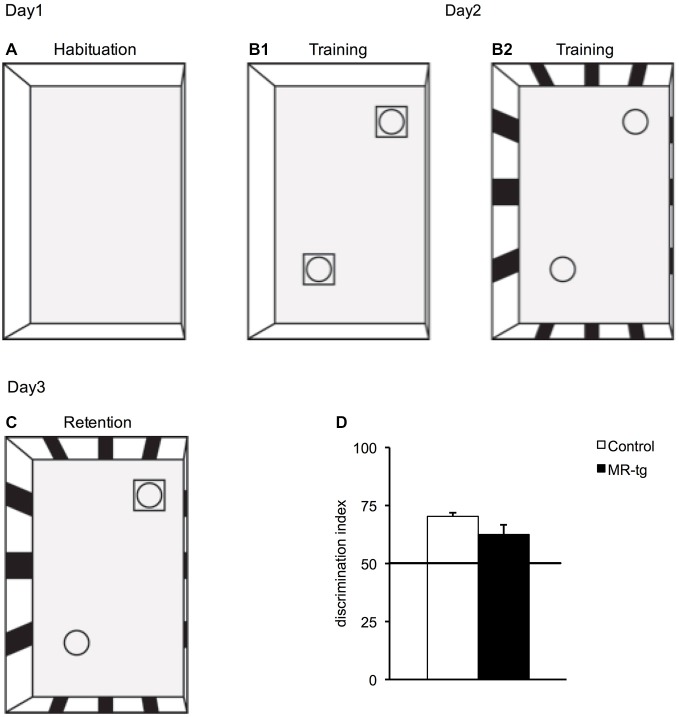
Effects of MR overexpression in object-in context. (A–C) Schematic representation indicating the setup of the object-in-context experimental paradigm: (A) On day1, mice were initially habituated in context A that had no objects. (B1) On day2, during training, mice were placed in the same context (context A) but with two identical objects and then placed in a novel context (context B) with two identical novel objects (B2). (C) On day3, the mice were placed in the context B but with one object being replaced by an object from the first context. (D) MR-tg and control mice exhibited no differences when tested for recognition memory of a novel object in the context B, as the discrimination index (DI) of MR-tg mice was not significantly different from that of the control mice. n = 14 per group.